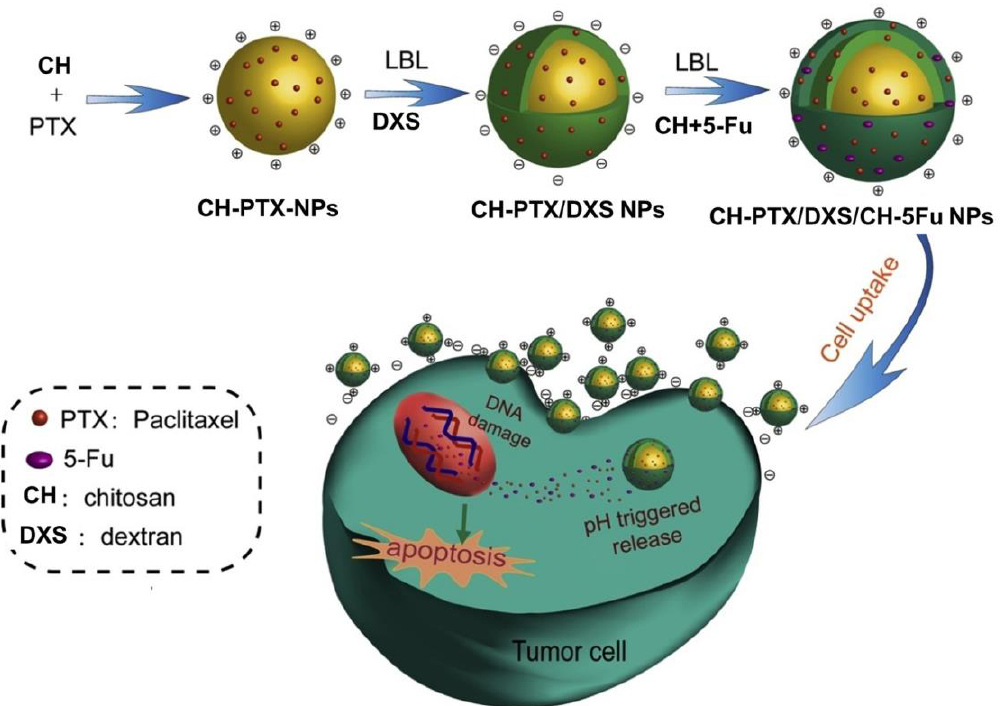
Figure 3. Schematic illustration of the preparation of dual-drug (PTX and 5-Fu)-loaded three layered CH/DEX/CH nanoparticles and cellular internalization and intracellular drug release. Adopted with permission from ref. [41] Copyright 2020 Elsevier B.V.